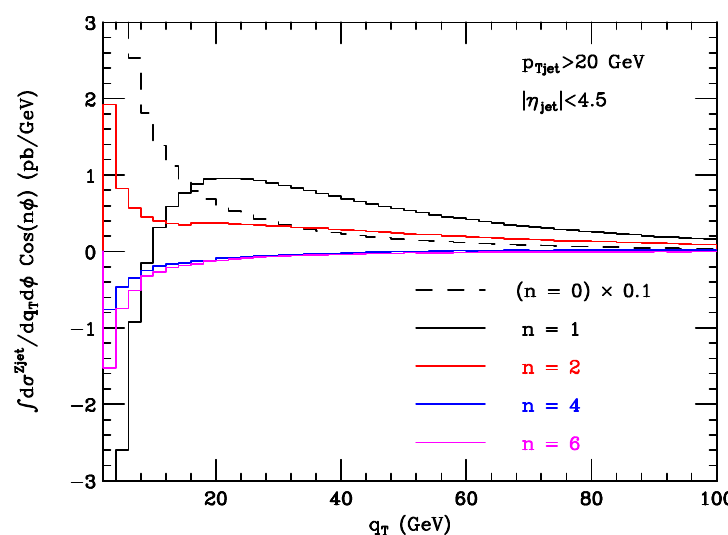
Figure 2 . Lowest-order transverse-momentum spectrum d(cid:27) n =dq T of cos ( n’ ) harmonics in the case of Z +jet